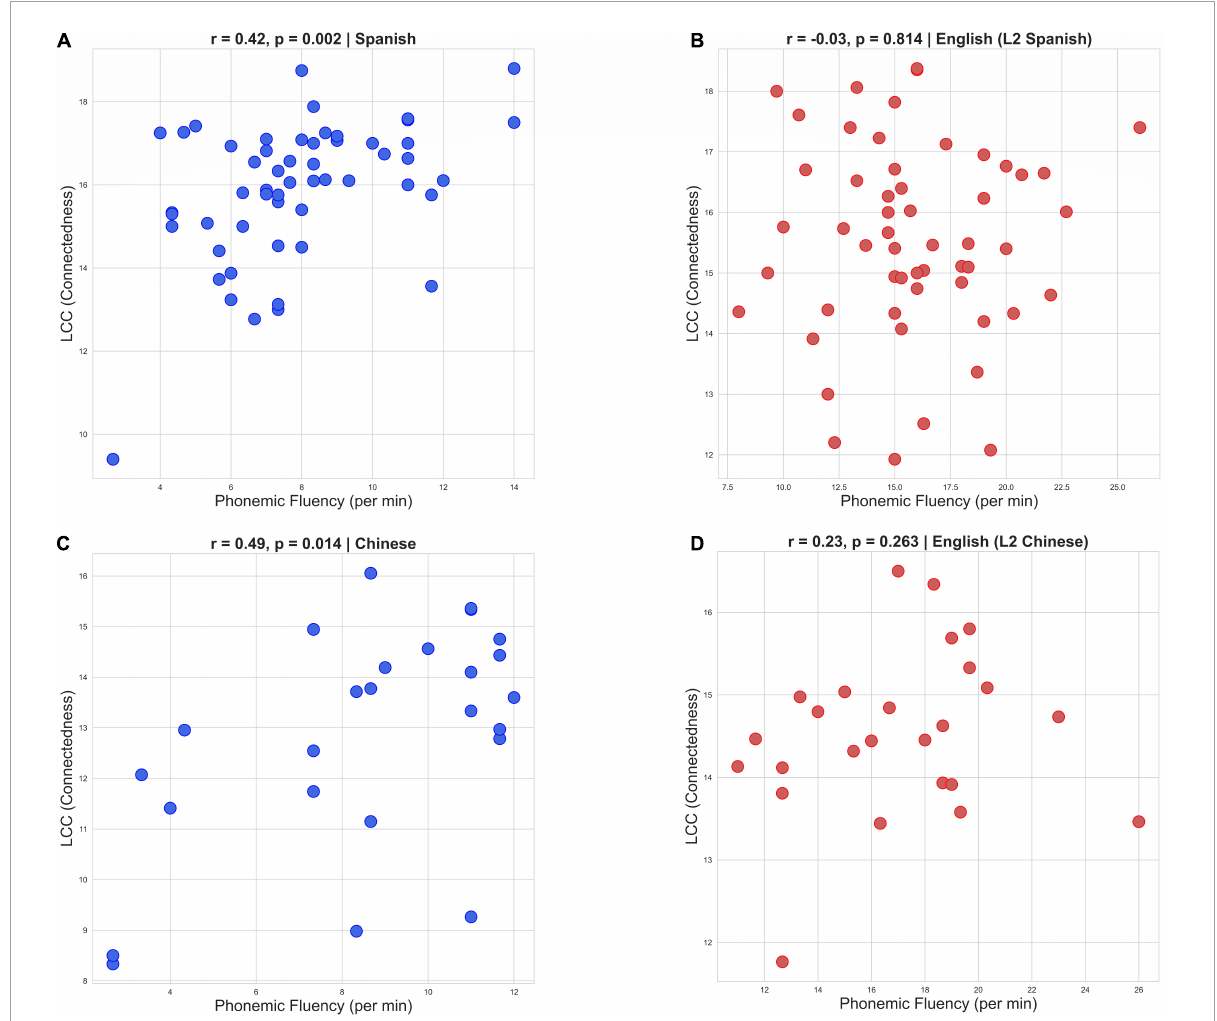
FIGURE3 Correlation scatterplots of the Largest Connected Component (LCC) measure in English and L1 Phonemic Fluency (B,D) and the LCC measure in the L2 and L2 phonemic fluency (Spanish and Chinese; A,C ).